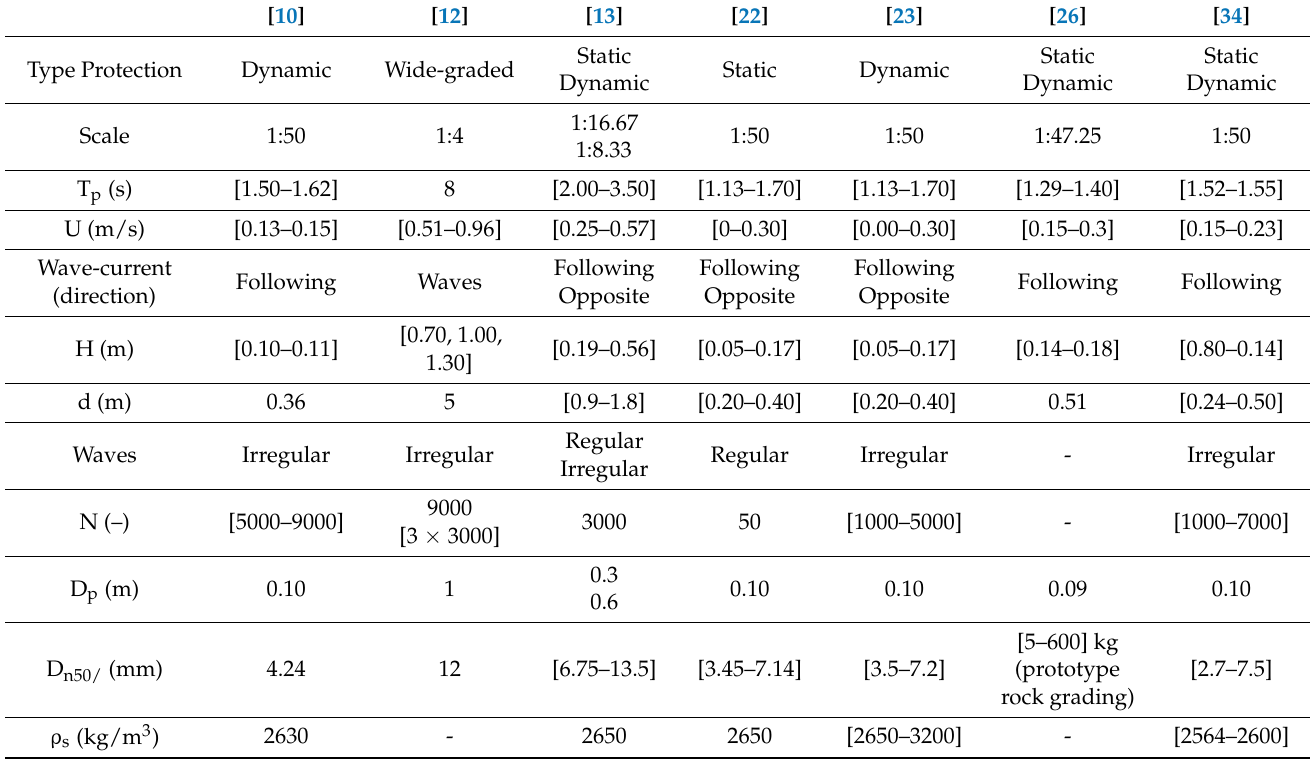
Table 1. Physical modelling studies on optimised scour protections (model